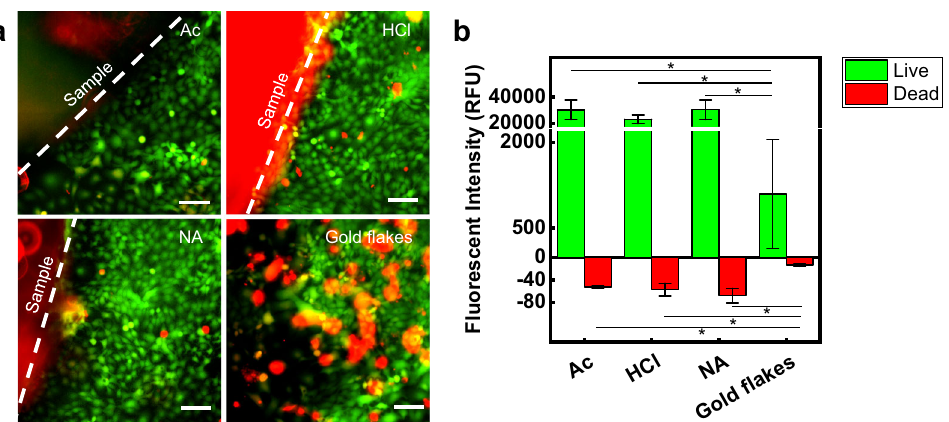
Fig. 6 Biocompatibility of UCDEs. a Confocal imaging of live/dead stained HaCaT cell cultured for 7 days (scale bar, 100 µ m). The sample group of a soaking method for UCDEs: Acetone (Ac), Hydrochloric acid (HCl), Nitric acid (NA), and gold fl akes. b Relative fl uorescence intensity of cells cultured for 7 days is presented as average and standard error of means (* p < 0.05